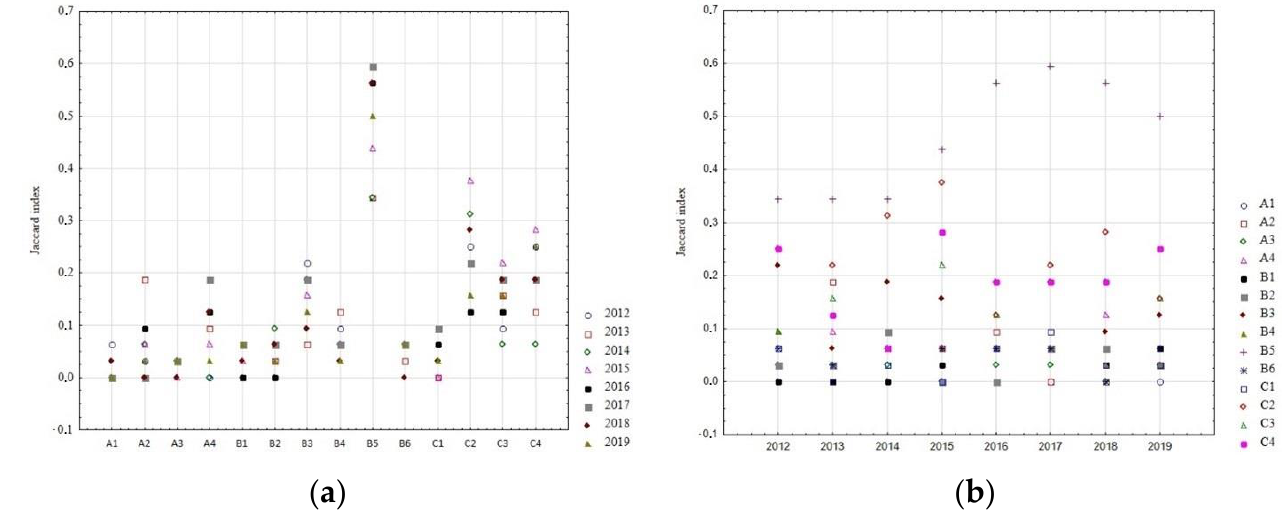
Figure 6. Jaccard index of individual results with results from variant D1 by variant ( a ) and time ( b ).